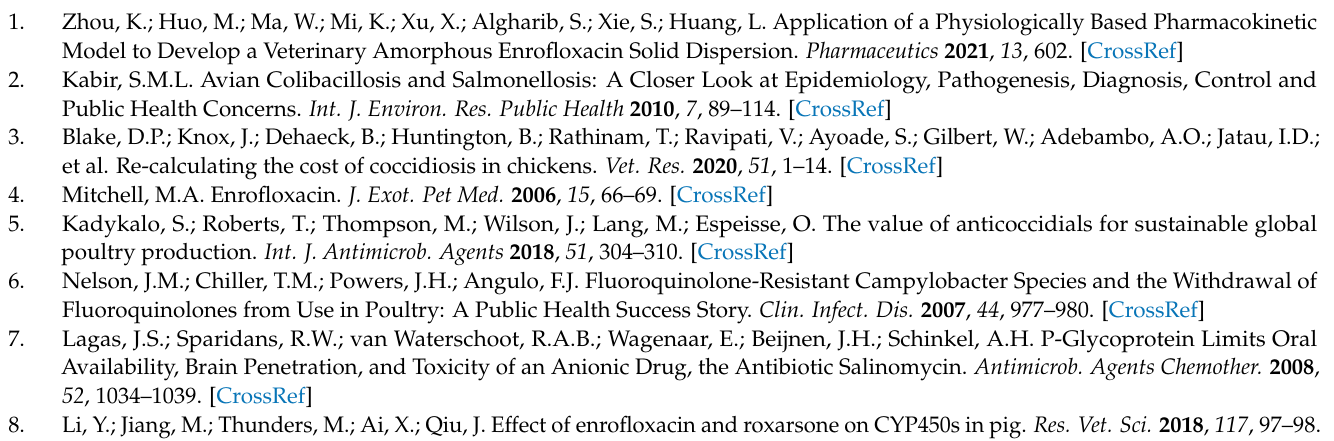
parameters of probe drugs and its metabolites. Table S4: Standard curve of probe substrates and products. Table S5: Accuracy and precision of probe substrates and products in chicken liver microsomes. Table S6: LOD and LOQ of probe substrates and products. Table S7: Standard curve of ENR, CIP and SAL. Table S8: LOD and LOQ of ENR, CIP and SAL. Table S9: Accuracy and precision of ENR, CIP and SAL. Table S10: Main pharmacokinetic parameters of ENR in broilers after single or combined administration (n = 6, Mean ± SD). * Statistical significance compared with ENR (7.5 mg/kg) is p < 0.05. Table S11: Pharmacokinetic parameters of CIP in chickens after single or combined administration (n = 6, Mean ± SD). * Statistical significance compared with ENR group (7.5 mg/kg) is p < 0.05; ** Statistical significance compared with ENR group (7.5 mg/kg) is p < 0.01. *** Statistical significance compared with ENR group (7.5 mg/kg) is p < 0.001. Table S12: Pharmacokinetic parameters of SAL in chickens after single or combined administration (n = 6, Mean ± SD). * Statistical significance compared with SAL group (6.0 mg/kg) is p < 0.05; ** Statistical significance compared with SAL group (6.0 mg/kg) is p < 0.01; *** Statistical significance compared with SAL group (6.0 mg/kg) is p < 0.001. Table S13: Molecule docking simulation of the compound with CYP3A4. Table S14: Molecule docking simulation of the compound with P-gp. Table S15: Molecule docking simulation of the compound with BCRP. Figure S1: Effects of ENR and SAL exposure on the viability of Caco-2 cells. Figure S2: The evaluation results of the CYP3A4 (PDB ID: 6MA7) model with VERIFY3D, ERRAT and PROCHECK software. Figure S3. The evaluation Figure S4. The evaluation results of the BCRP (PDB ID: 6ETI) model with VERIFY3D, ERRAT and PROCHECK